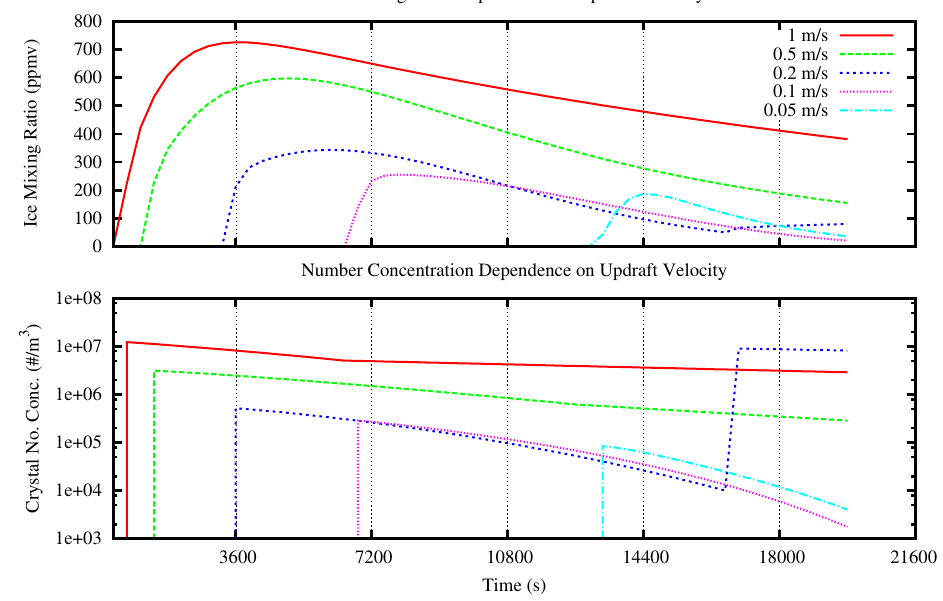
Fig. 2. Sensitivity of the ice mixing ratio to vertical velocity. This shows the evolution of ice amount as water vapour volume mixing ratio and crystal number concentration derived from the homogeneous nucleation parameterisation. These figures are from the unit testing of the parameterisation separately from the CTM. The initial values of temperature, pressure, etc. are fixed and only the vertical ascent velocity is changed. The time axis tic marks are chosen to show a typical CTM sample